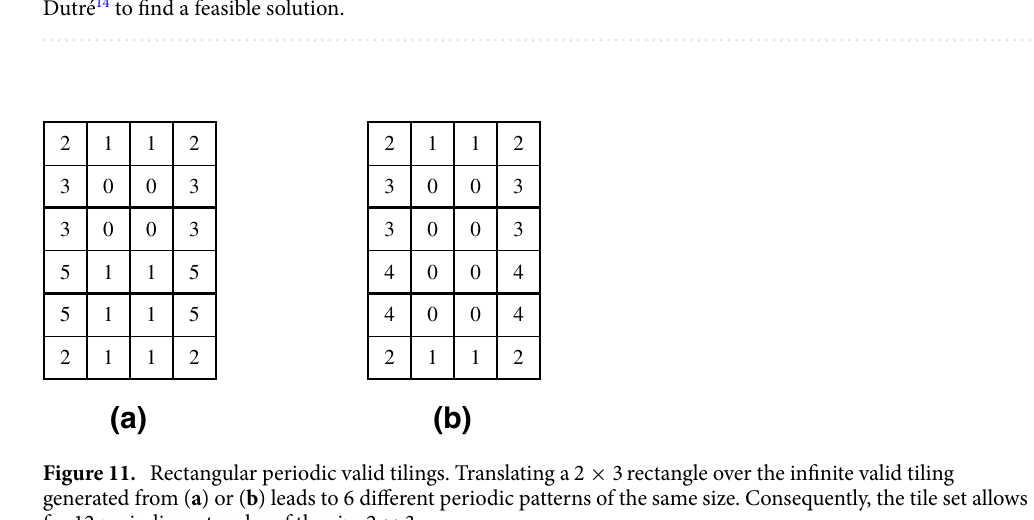
Table 3. Periodic tile packing problem: comparison of core times needed to find a single feasible solution by integer programming (second column) and by the backtracking method (third column) proposed in Lagae and Dutré 14 to find a feasible solution.